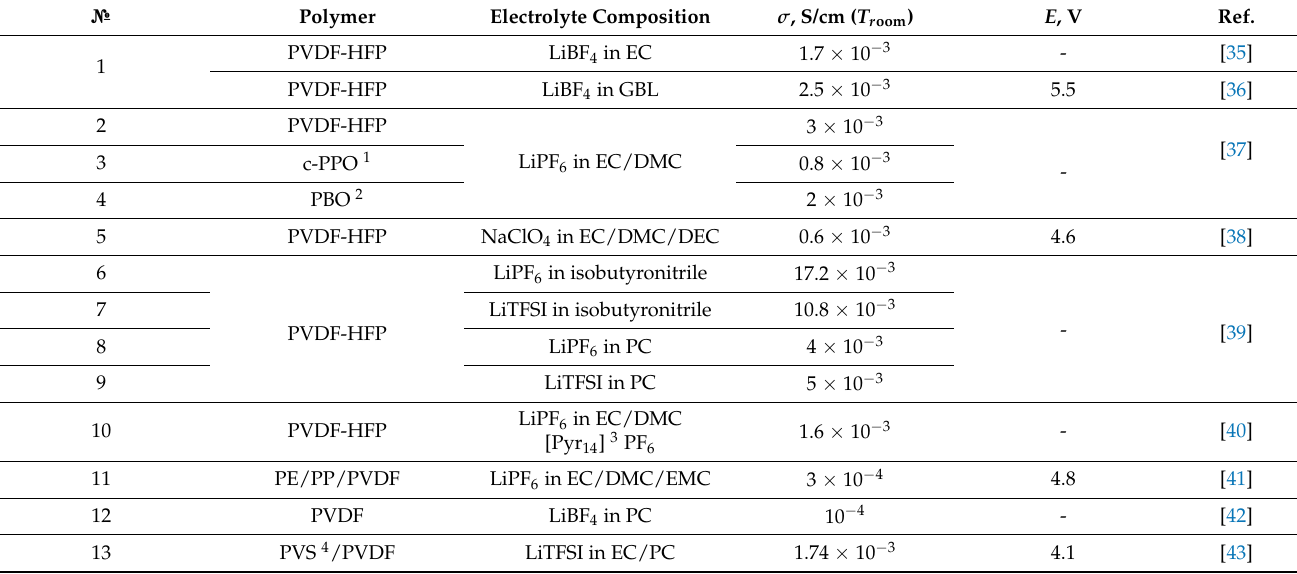
Table 2. Composition and characteristics of polymer gel